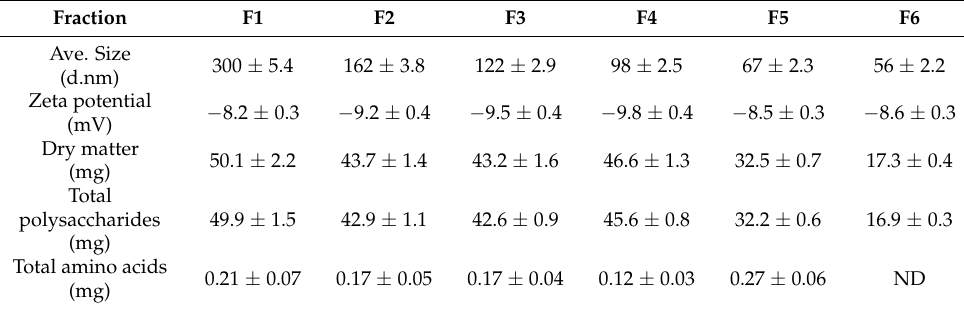
Table 1. Characteristics of isolated colloidal particle